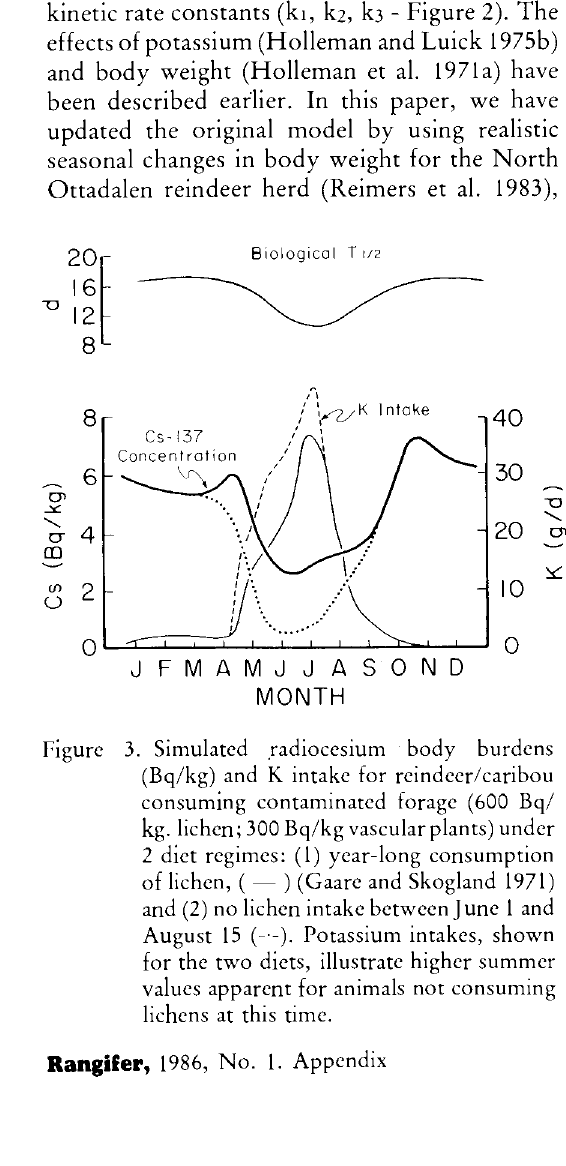
Figure 4. Simulated radiocesium body burden for reindeer/caribou consuming forage conta minated by radionuclide fallout on April 25. Simulated radiocesium concentration in contaminated lichen equals 600 Bq/kg for both 1986 and 1987; simulated radiocesium concentration in vascular plants equal 200 for 1986 and 20 Bq/kg for 1987. Results are shown for animals under 2 diet regimes: (1) year-long consumption of lichen (o - o) (Gaare and Skogland 1971) and (2), no lichen intake between June 1 and April 15 (•-•).